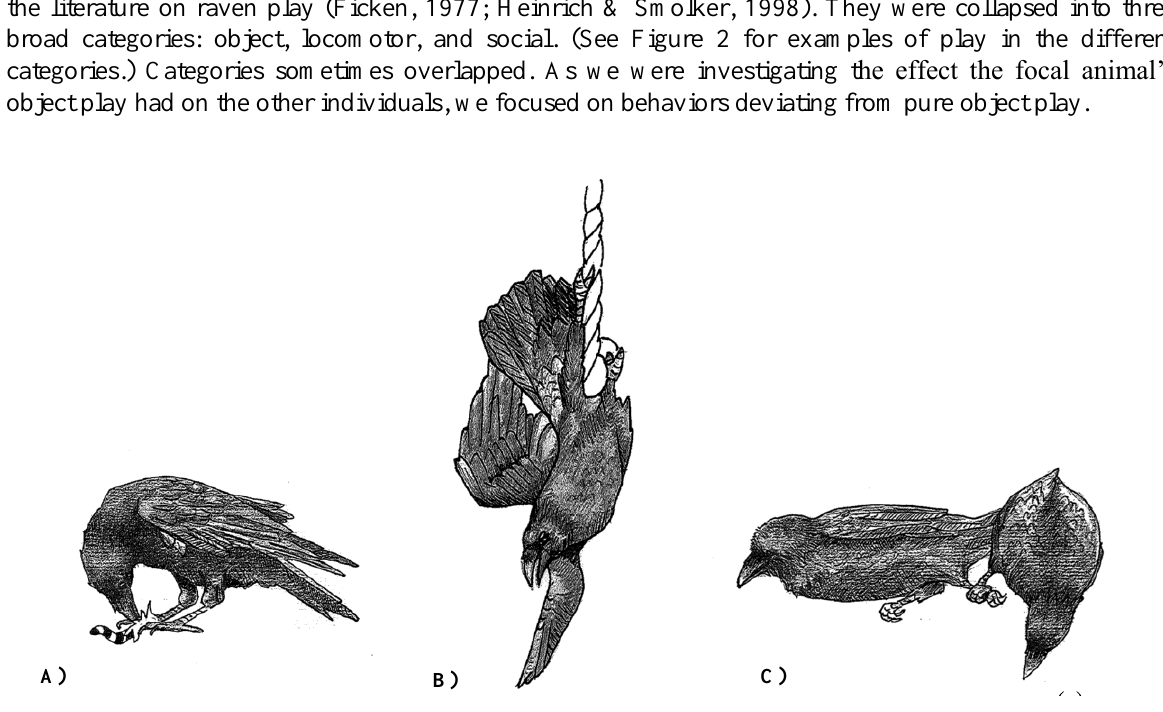
Figure 2. Examples of play behaviors in three broad categories: A) object play, B) locomotor play, C) social play. (Illustration by Helena